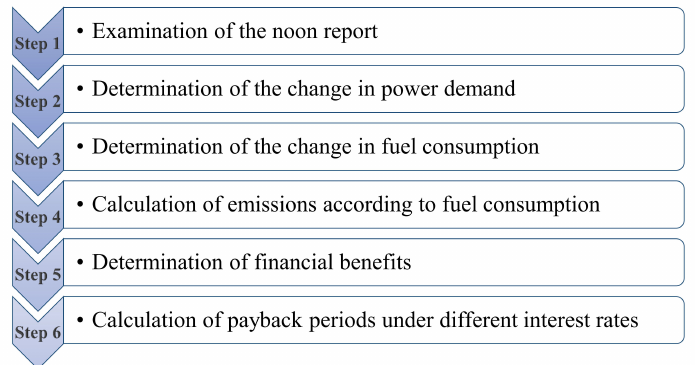
Figure 3. The methodology of the study.